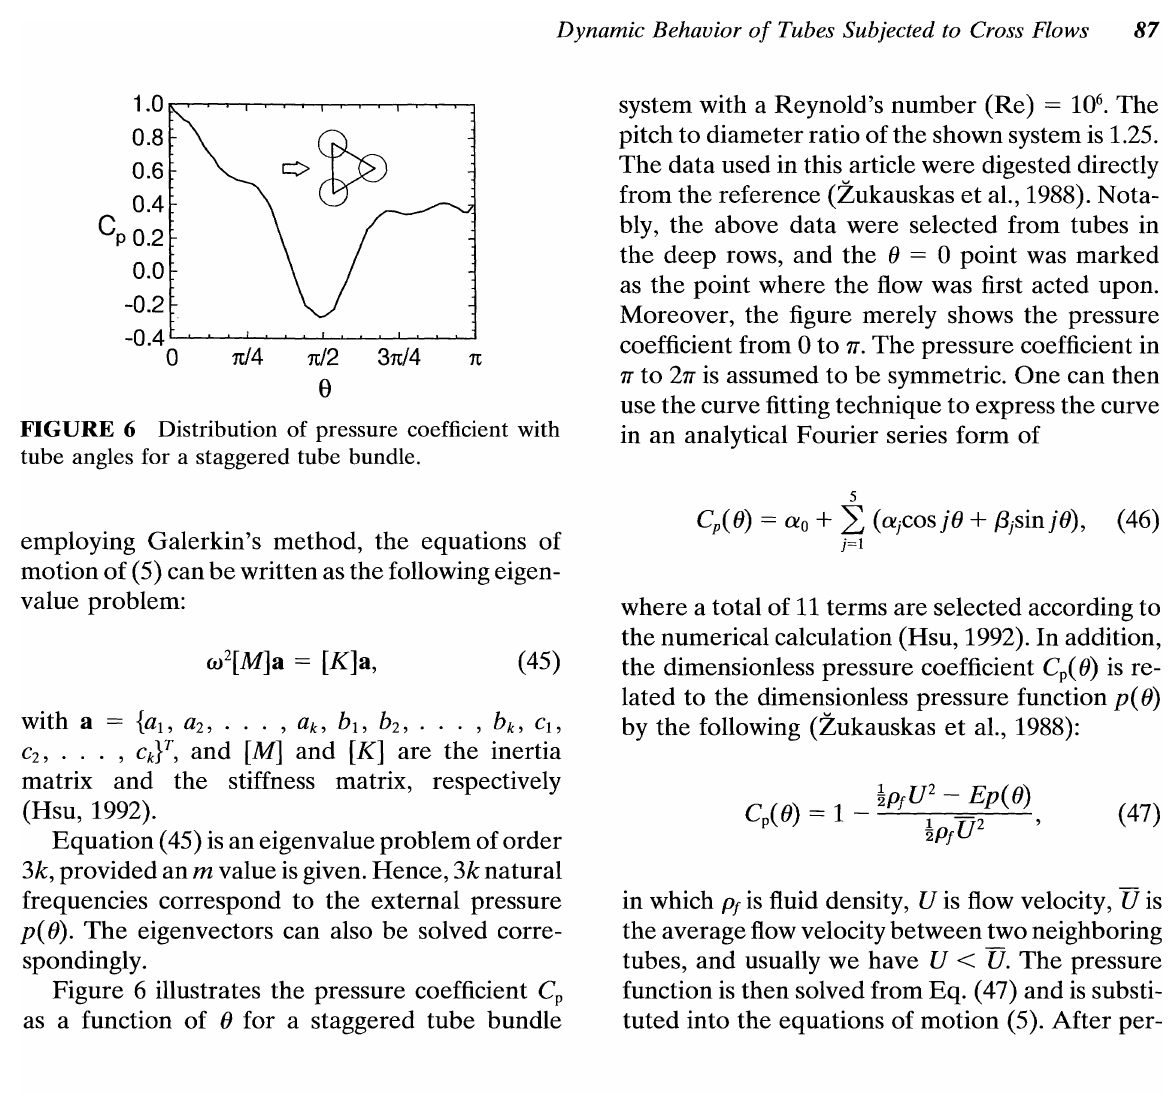
Table 2. Natural Frequencies of Staggered Tube Bundle Bending Frequency,